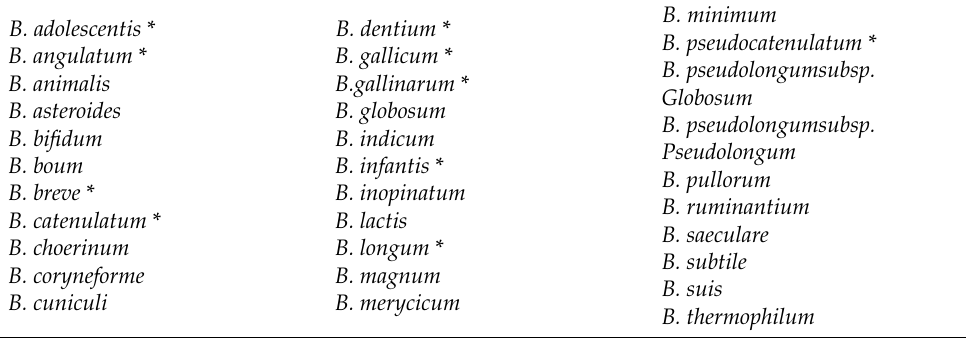
Table 1. Bifidobacterium